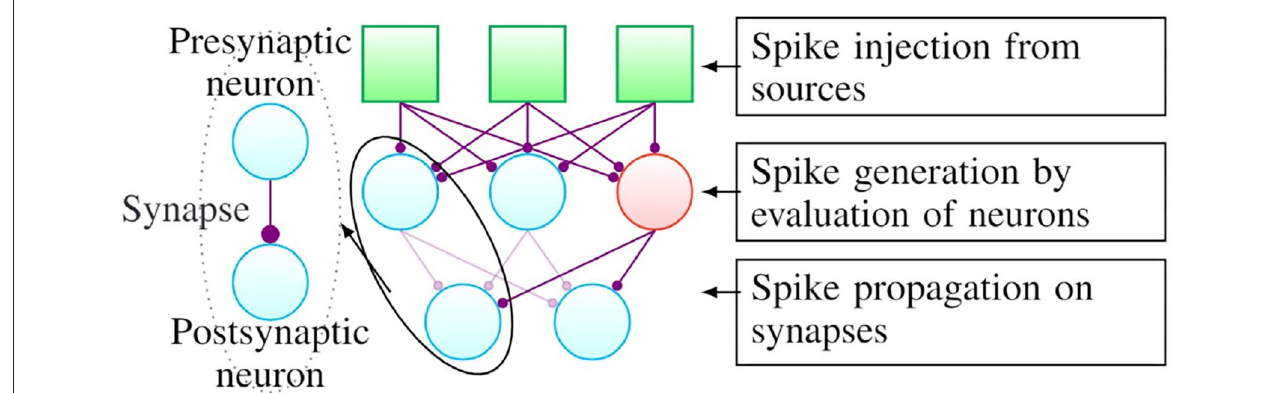
FIGURE 1 | A generic structure of spiking neural networks.